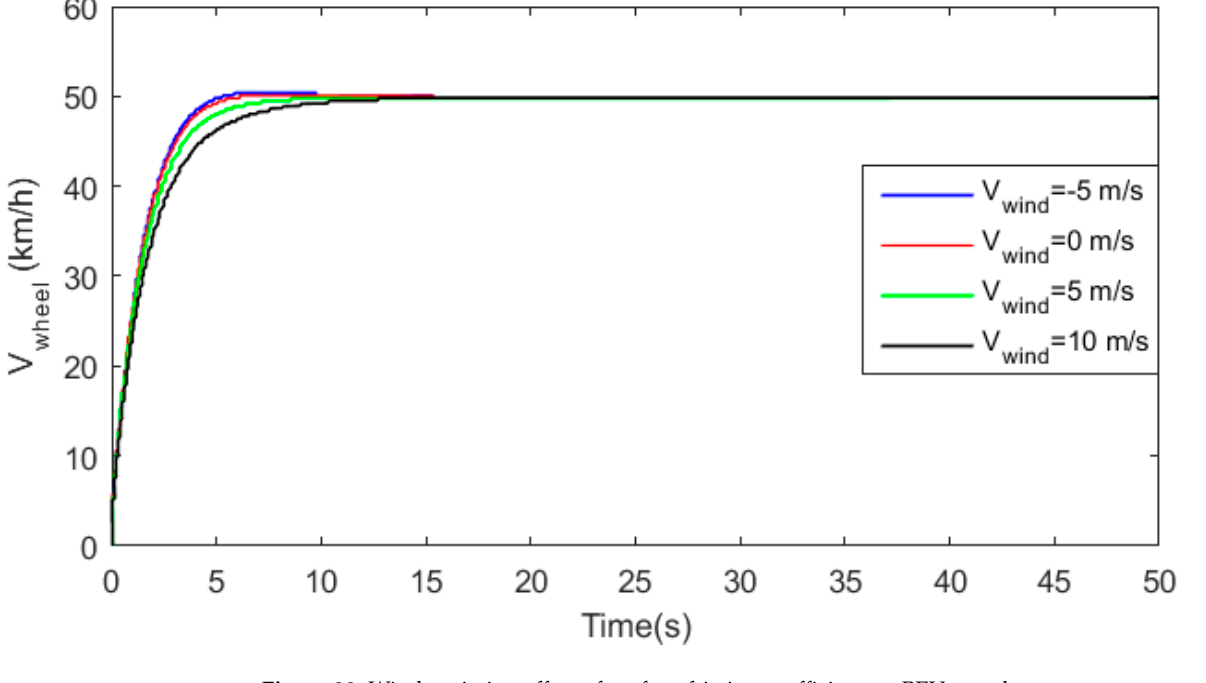
Figure 38. Wind variation effect of surface-friction coefficient on BEV speed response.